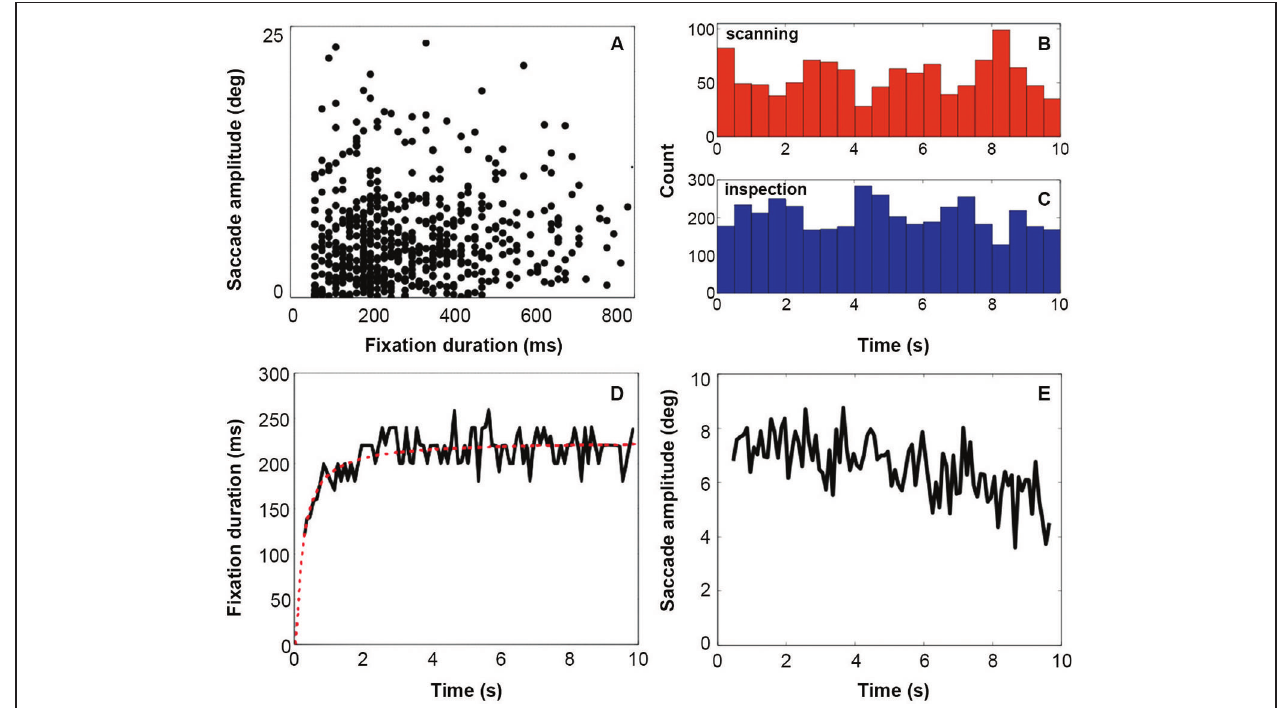
FIGURE 2 | Eyetracking results . Panel A indicates the distribution of fixations and following saccades plotted in terms of fixation duration against saccade amplitude. Panels B and C show the distribution of all viewing events (fixation followed by a saccade) of each viewing mode across the display of the stimulus (red = scanning, blue =